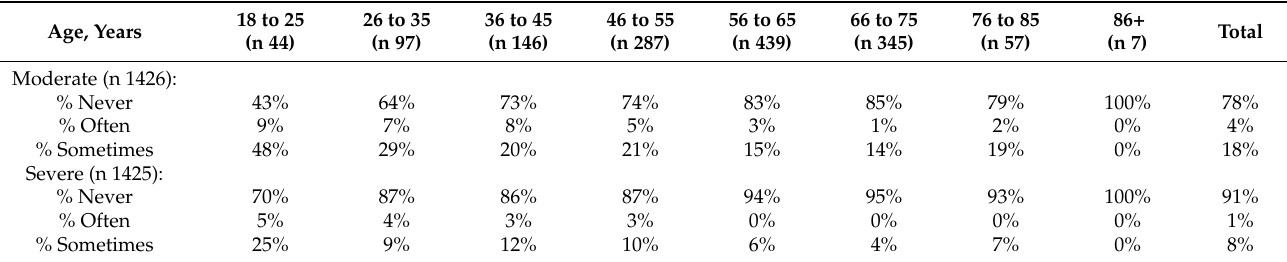
Table 1. Responses to food insecurity